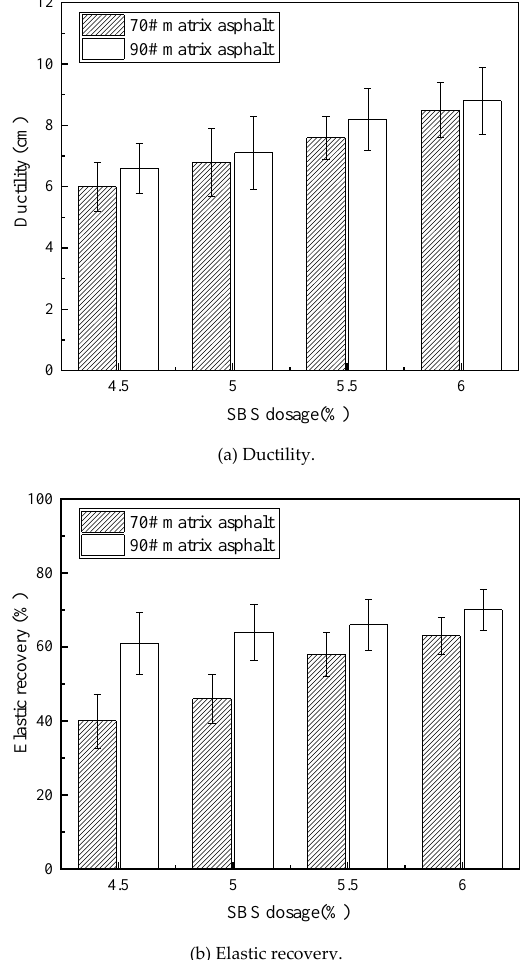
Figure 3. Ductility and elastic recovery result of matrix asphalt and SBS modified asphalt. 145